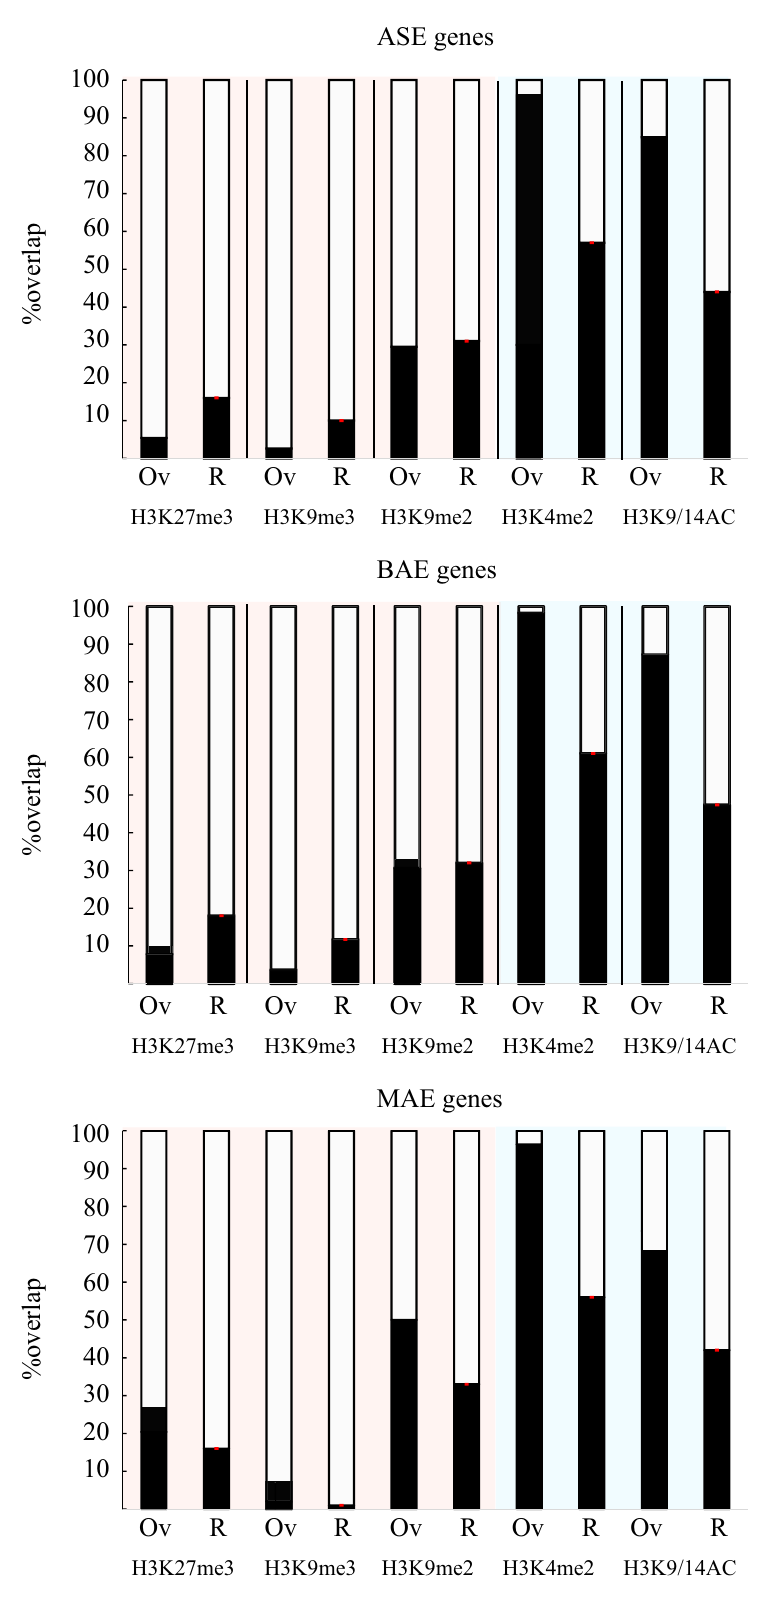
Figure 3. Association of epigenetic marks and allele-specific expression in P. tricornutum . Percentage overlap (‘Ov’) between annotated genes within the MAE, ASE, and BAE categories and H3K27me3, H3K9me3, H3K9me2, H3K4me2 and H3K9- 14AC peaks. ‘R’ represents mean %overlap over 100 iterations between each gene categories and a random histone peak positioning. Overlap were calculated using R software 43 R version 3.6.1 (2019-07-05) (https ://cran.r-proje ct.org/bin/windo ws/ base/old/3.6.1/) and the genomation R package computation 44